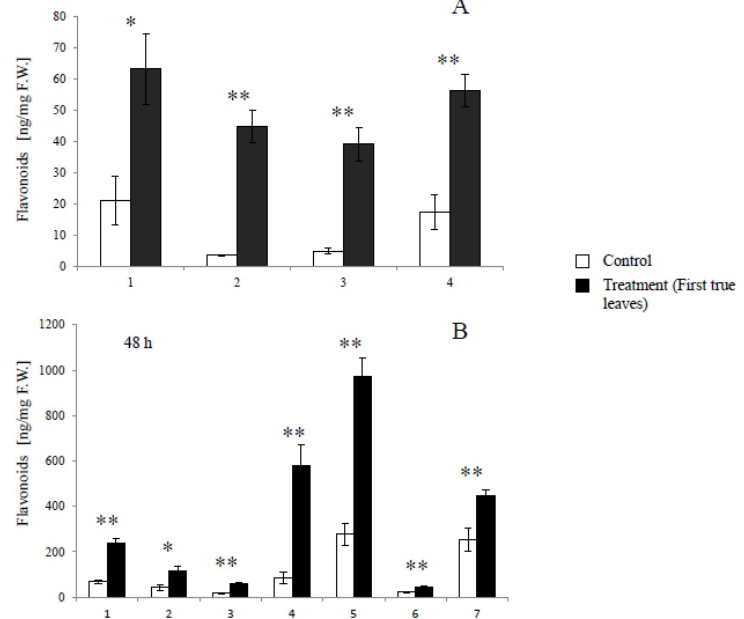
Figure 4. Quantitative estimates of soybean leaf flavonoids induced by herbivore and herbivore gut content elicitation. Average (n = 3–4; ± S.E.M.) flavonoid levels in soybean leaves challenged with ( A ) S. litura herbivory and ( B ) S. litura gut contents. (1) Daidzin; (2) 4’,7-Dihydroxyflavone; (3) Daidzein; (4) Formononetin; (5) Malonyldaidzin; (6) Ononin; (7) Malonylononin. The data were analyzed using the Student’s t -test and asterisks denote